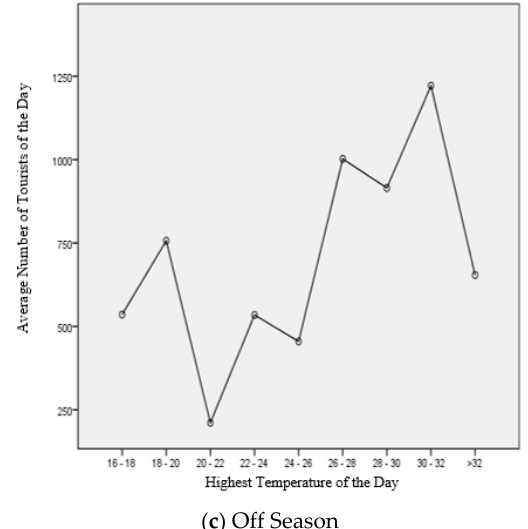
Table 2. Temperature and precipitation to estimate the adj- R 2 value of the regression equation.